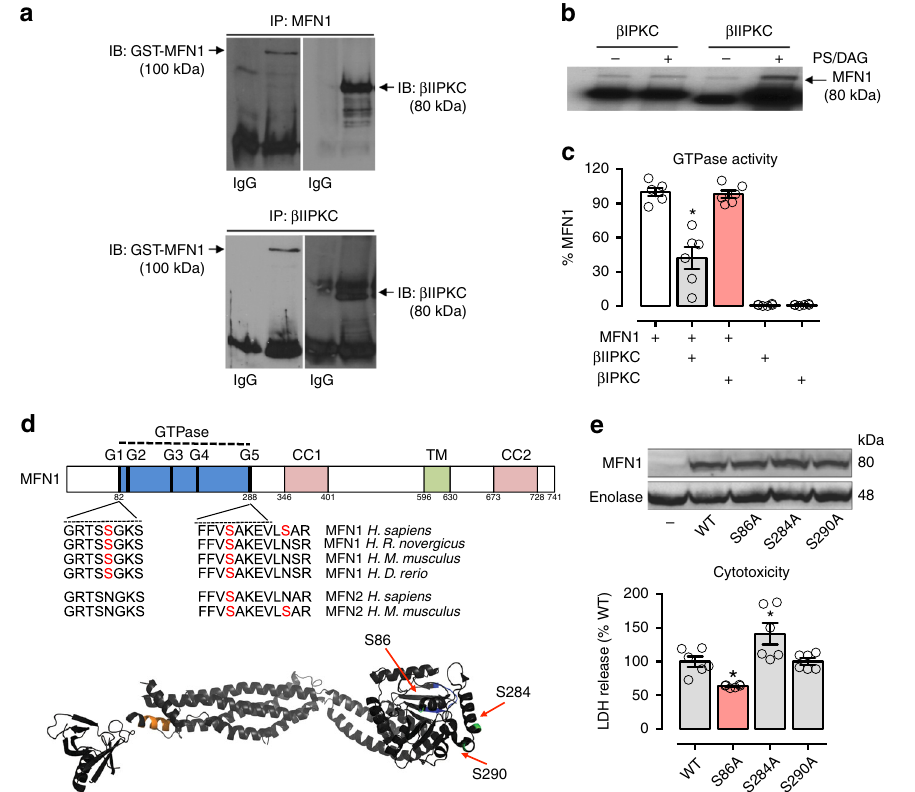
Fig. 4 Characterization of Mfn1- β IIPKC protein – protein interaction. Recombinant Mfn1 (GST-Mfn1, 25 ng) was incubated with recombinant β IIPKC (GST- β IIPKC, 25 ng) in the presence and absence of phosphatidylserine and diacylglycerol (PS/DAG/Ca 2 + , PKC activators) for 30 min at 37 °C. a Co- immunoprecipitates with anti-Mfn1 and β IIPKC were analyzed by western blot. b Mfn1 phosphorylation was evaluated using radioactive [ 32 P] 32 P-ATP incorporation after incubation with either β IIPKC or its alternative splicing β IPKC in the presence and absence of classic PKC activators. Representative blots of three independent experiments. c GTPase activity of Mfn1 determined in the presence of active β IIPKC or its alternative splicing β IPKC ( n = 6 per group). d Conservation of the β IIPKC phosphorylation in human orthologs of Mfn1 in rat, mouse, and zebra fi sh and Mfn2 in mouse. Ribbon presentation of the 3D structure of Mfn1 phosphorylation at the β IIPKC site (PDB: 5GOM). e Individual replacement of serine by alanine at residues 86, 284, and 290 in Mfn1 knockout MEFs. Cells were transfected with the following constructs: WT, S86A, S284A and S290A. 48 h after transfection cells were incubated